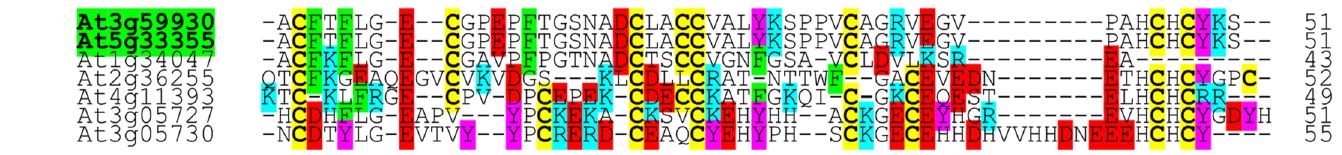
Figure 2. Sequence alignment of mature peptides encoded by CRP0770 genes. At3g59930 and A5g33355 (marked green) encode identical peptides. Sequences were aligned with Clustal Omega and gaps were introduced to align the cysteine residues (yellow). Blue marks, basic amino acids; red, acidic amino acids; green, phenylalanine; pink, tyrosin.